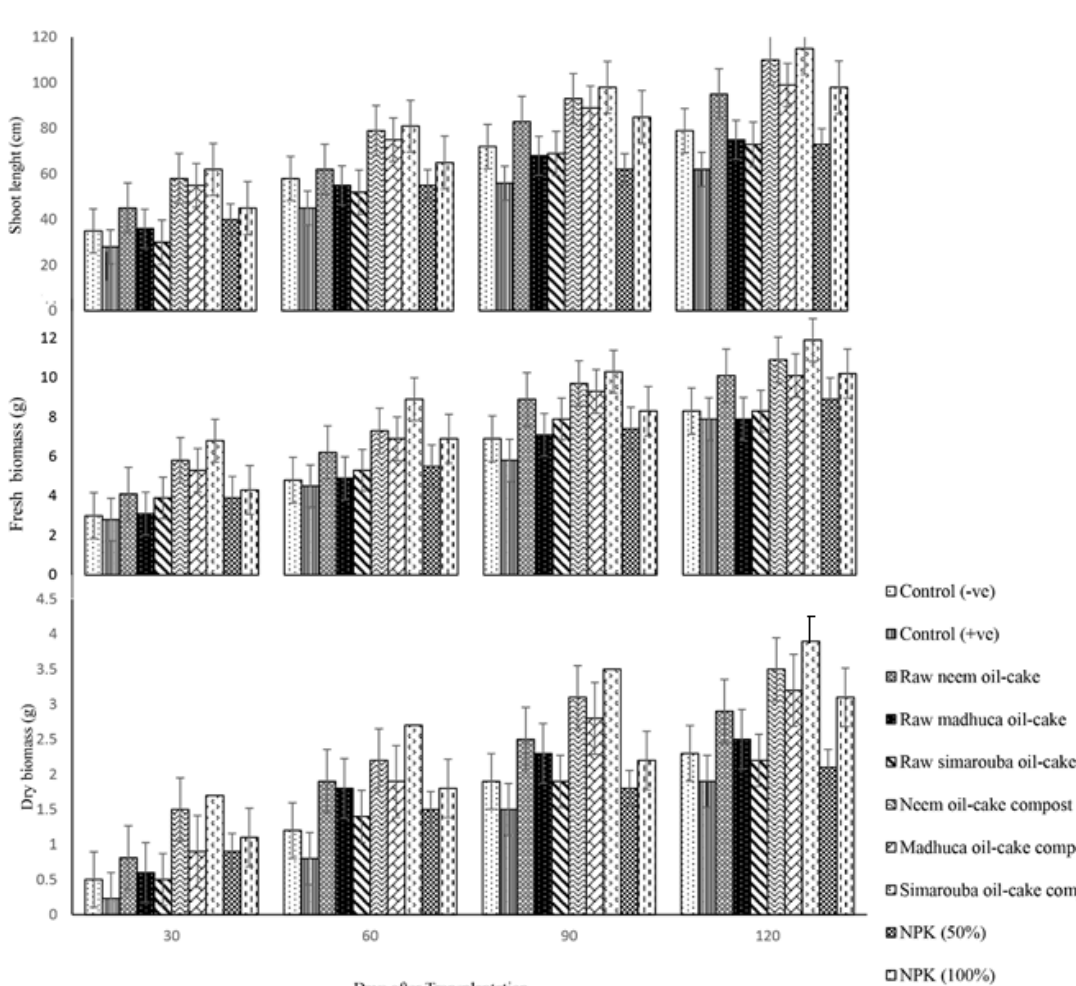
Fig. 1 Effect of amendment with raw and composted oil-cakes of neem, madhuca and simarouba on shoot length and fresh and dry biomass of chilli plants grown in the